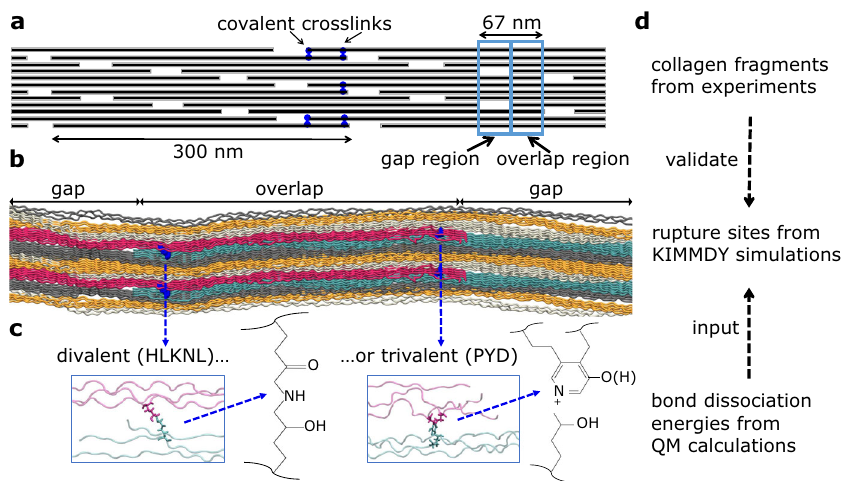
Fig. 1 | Collagen structure, spanning multiple length scales, and our corre- sponding methods. a 2D projection of the staggered arrangement of collagen triple helices, each 300nm. This results in the typical overlap and gap regions of collagen, including the 3D braiding of triple helices. b Our atomistic model span- ning one overlap (middle) and about one gap region (split into two parts) of